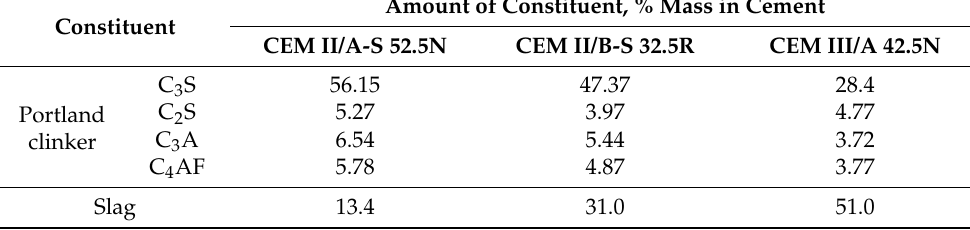
Table 2. Slag-limestone cement phase composition.